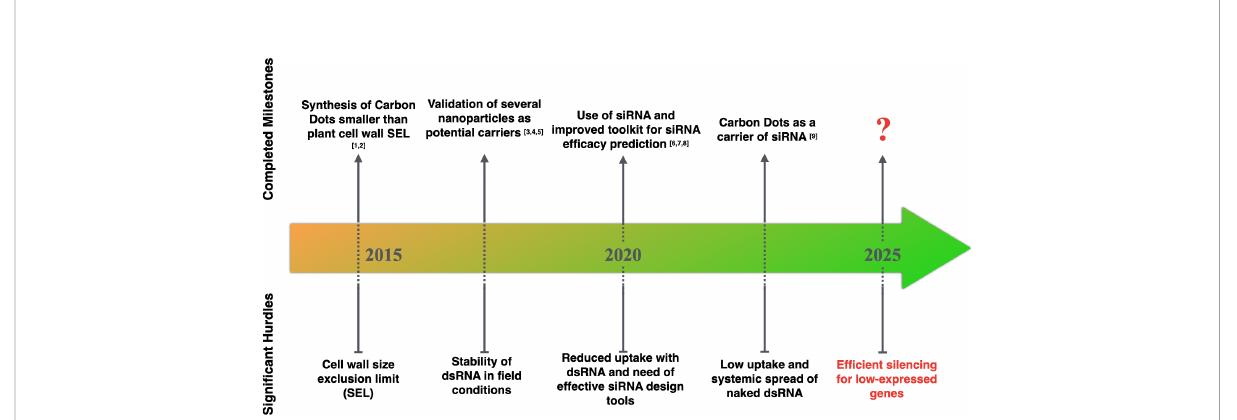
FIGURE 2 Signi fi cant milestones achieved for RNA-based ectopic application. [1, 2]: Wang et al., 2014; Schwartz et al., 2020, [3-5]: Mitter et al., 2017, Zhang et al., 2019a, Demirer et al., 2020, [6-8]: Ahmed et al., 2020, Bennett et al., 2020, Sciabola et al., 2021, [9]: Delgado-Mart ı ́ n et al.,